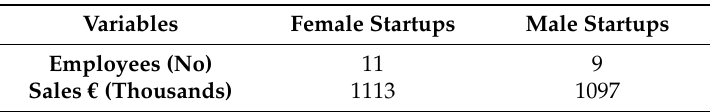
Table 5. Average company